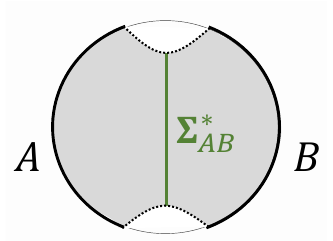
Figure 1 . Holographic entanglement of puri(cid:12)cation. The shaded region is the entanglement wedge of the subsystems A and B in holographic CFTs (we take a constant time slice of global AdS). The dotted lines are the minimal surface whose area gives S AB . The entanglement wedge cross-section E W ( A : B ) is de(cid:12)ned by the minimal area (divided by 4 G N ) of codimension-2 surfaces which divide the entanglement wedge into two parts. In this (cid:12)gure this minimal surface is denoted by (cid:6) (cid:3) P (cid:3) E W ( A : B ) = Area( AB ) 4 G N